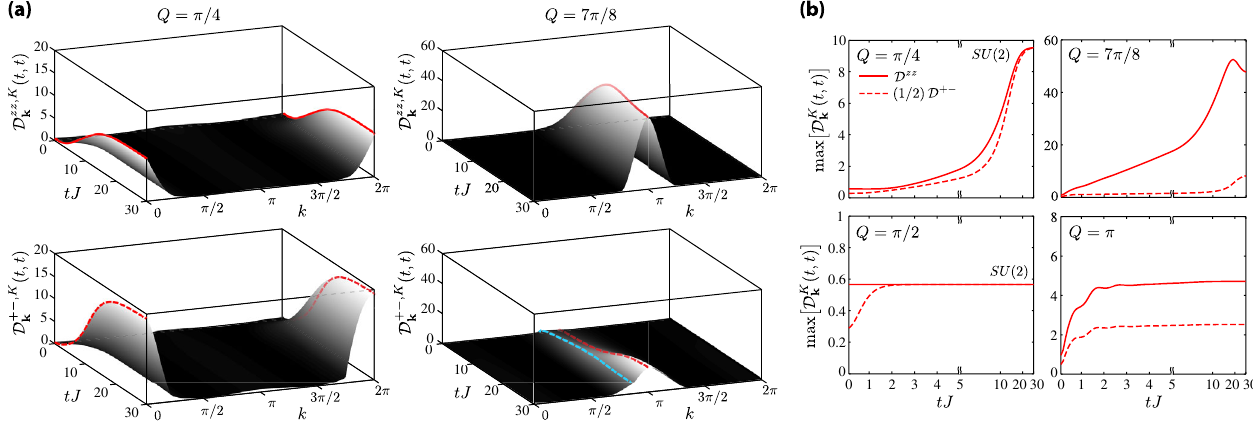
FIG. 5. Dynamics of exchange-field fluctuations. (a) The out-of-plane (top) and in-plane (bottom) exchange-field fluctuations as a function of time and momentum k ¼ ð k; k; k Þ for Q ¼ π = 4 (left) and Q ¼ 7 π = 8 (right). The red lines indicate the most enhanced mode in the long-time limit; the dashed blue line in the lower right plot corresponds to the k ¼ Q in-plane mode, which initially exhibits the strongest enhancement of correlations. (b) The evolution of the late-time most enhanced mode for Q ¼ π = 4 ; π = 2 (left) and Q ¼ 7 π = 8 ; π (right). In cases where the system thermalizes, left column, SU ð 2 Þ symmetry emerges in the long-time limit, while it is broken in the prethermal case Q ¼ 7 π = 8 and for Q ¼ π , right column. In the latter case, the system can exhibit true long-range order, provided its effective temperature is below the critical temperature of the equilibrium phase transition and can thus be thermal and simultaneously break SU ð 2 Þ